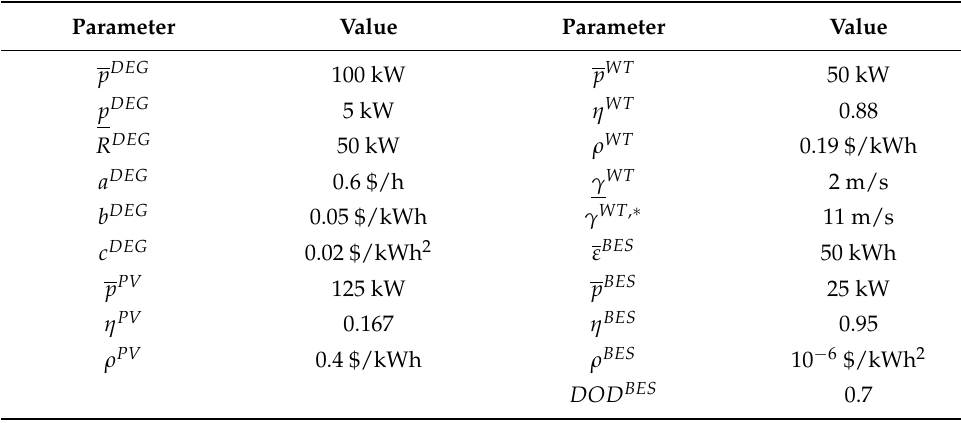
Figure 8. Time-of-Use tariff applied to non-shiftable consumers in simulations. Table 2. Parameters considered in simulations